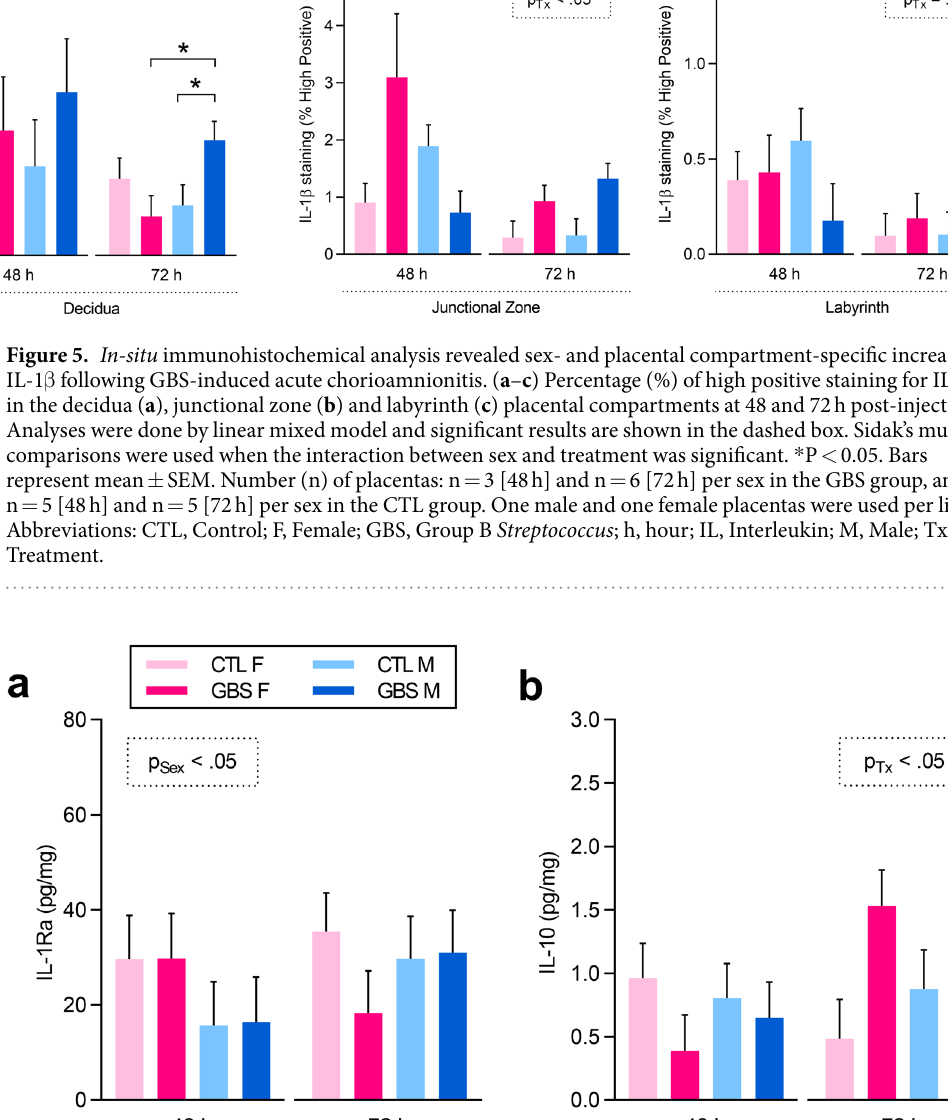
of human twins, in which males have been found to have increased placental inflammation and lesions compared to females 47 . The perinatal period is critical for brain development. Dysregulation of maternal cytokine levels during gesta- tion has been associated with disturbances of motor and cognitive development, leading, for instance, to cerebral palsy, learning impairments, or autism spectrum disorders 48,49 . We previously showed using the same model that in-utero GBS-exposed rats presented sexually dichotomous impairments characterised by early autistic-like traits in males – but not in females – associated with forebrain white matter tract alterations 32 . This was also shown in other rodent models of maternal immune activation triggered by other pathogen-associated molecular patterns, namely lipopolysaccharide from E . coli and Poly(I:C) mimicking a viral infection 50–54 . Male – but not female